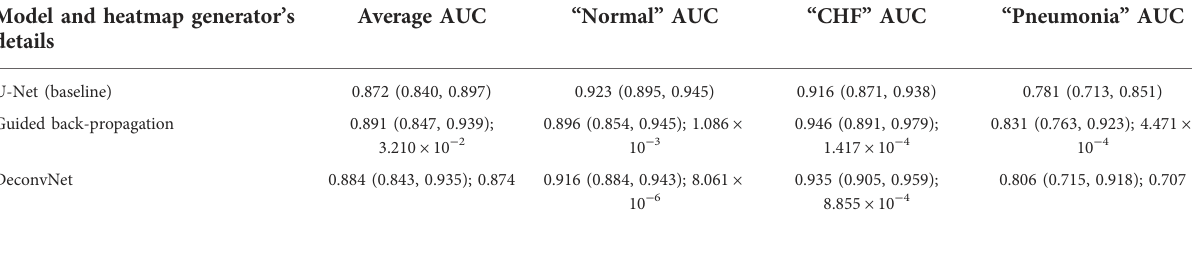
TABLE 2 Comparing the output AUC values between (12) ’ s U-Net model and a U-Net with different derived heatmaps (GBP or deconvNet) for the Experiment Set 1 (the value preceding the parenthesis is the 50th percentile value and the values in parenthesis are 2.5th and 97.5th percentile values, and the value after a semicolon is the p